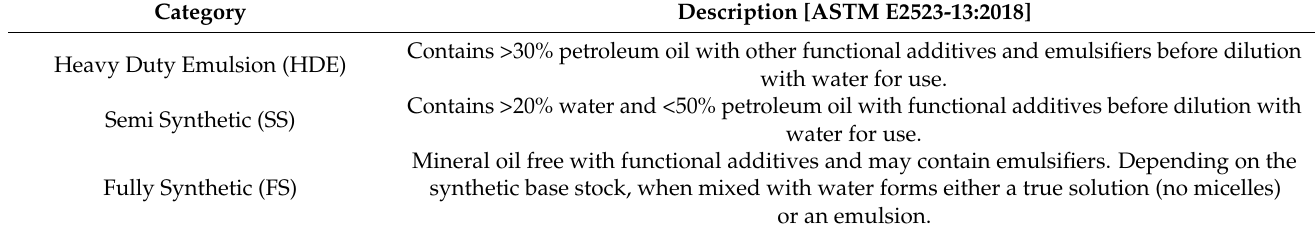
Table 1. Classification of MWF